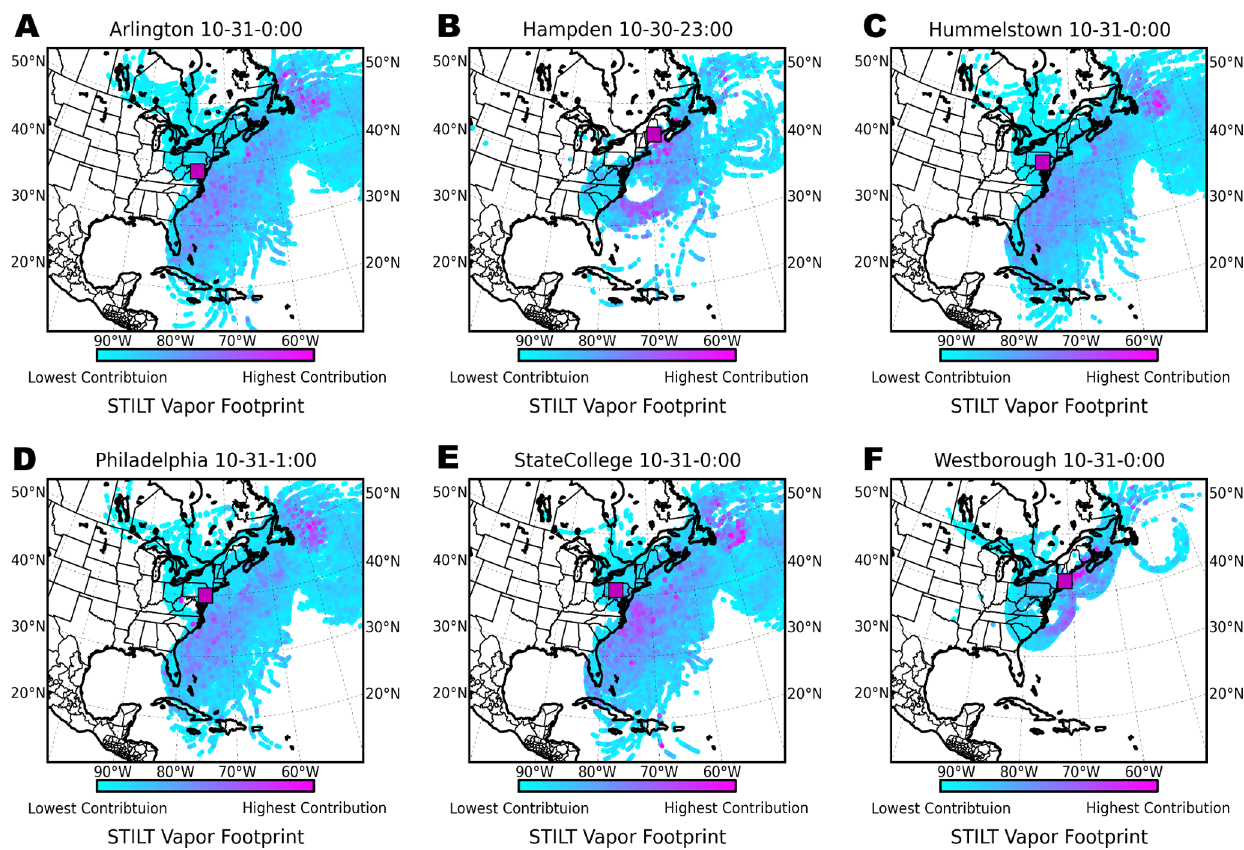
Figure 4. Estimates of vapor source regions. ( A–F ) Back trajectory estimates from the STILT model of regions contributing moisture to the atmosphere above six locations where precipitation samples were collected on October 31st 2013, 00 hrs EDT.